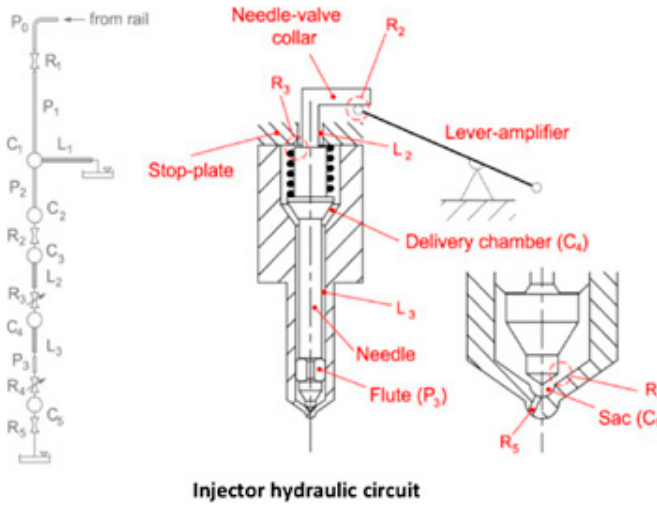
Figure 2. Schematic of the indirect-acting piezoelectric injector.